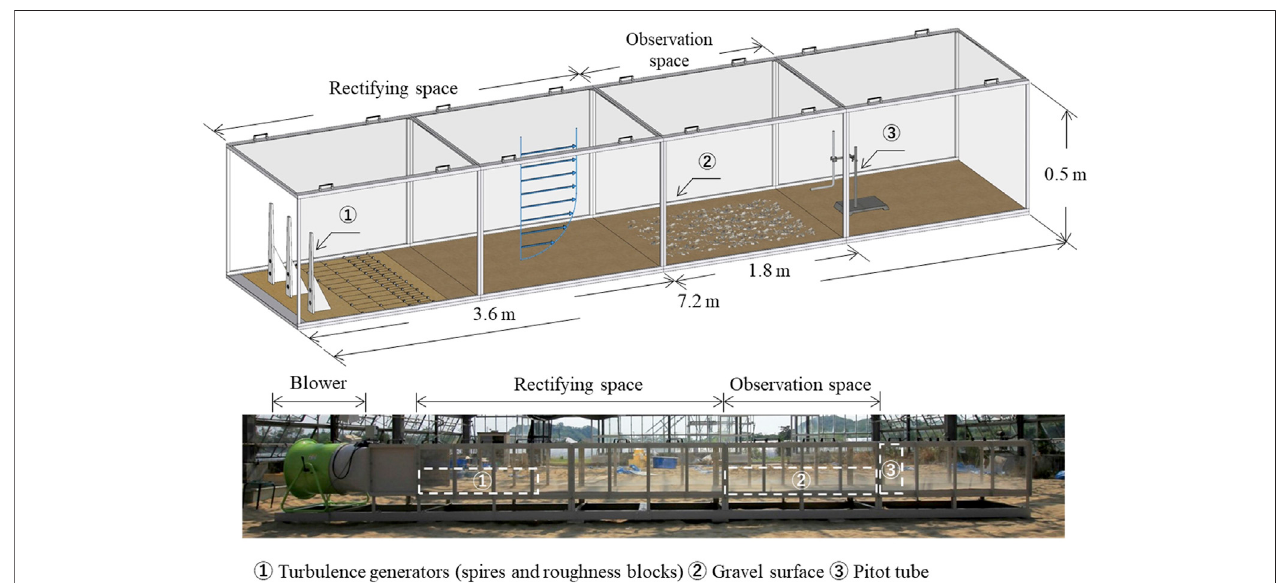
FIGURE 1 | Layout of experimental setup and photograph of the wind